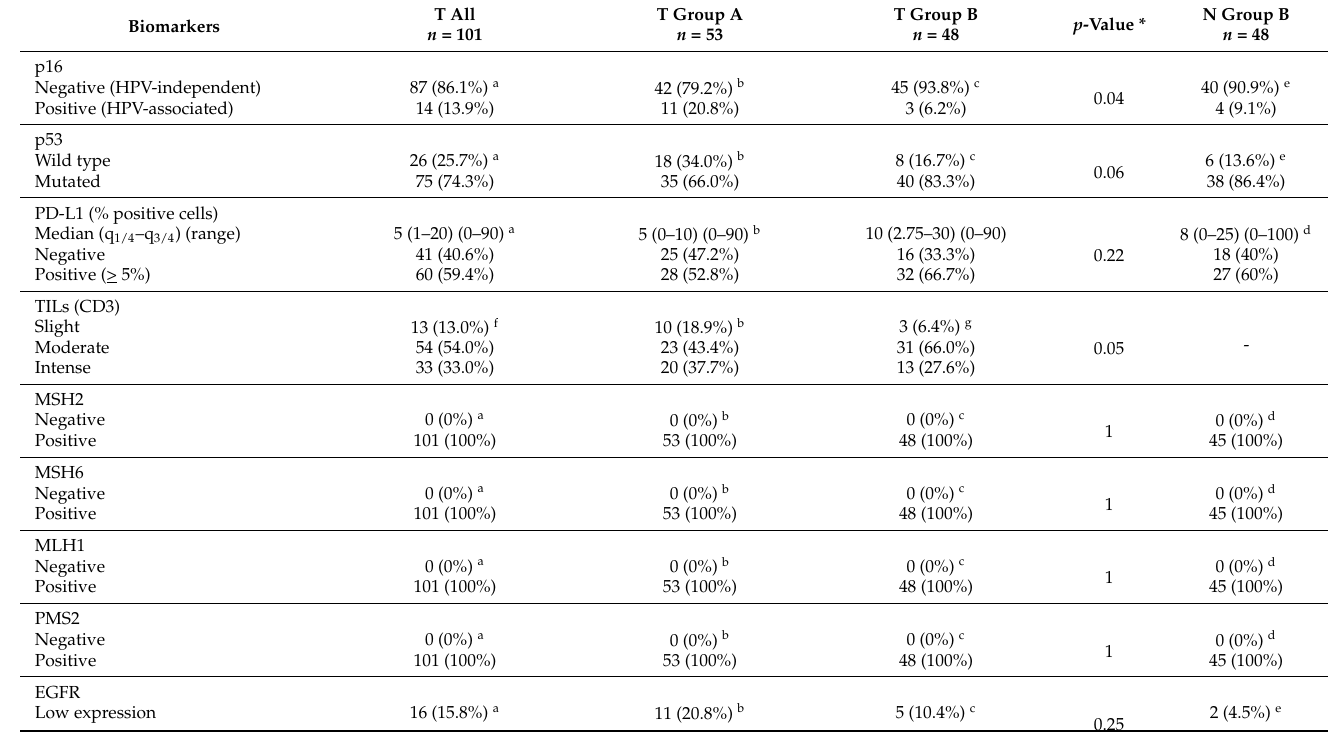
Table 2. Immunohistochemical panel.